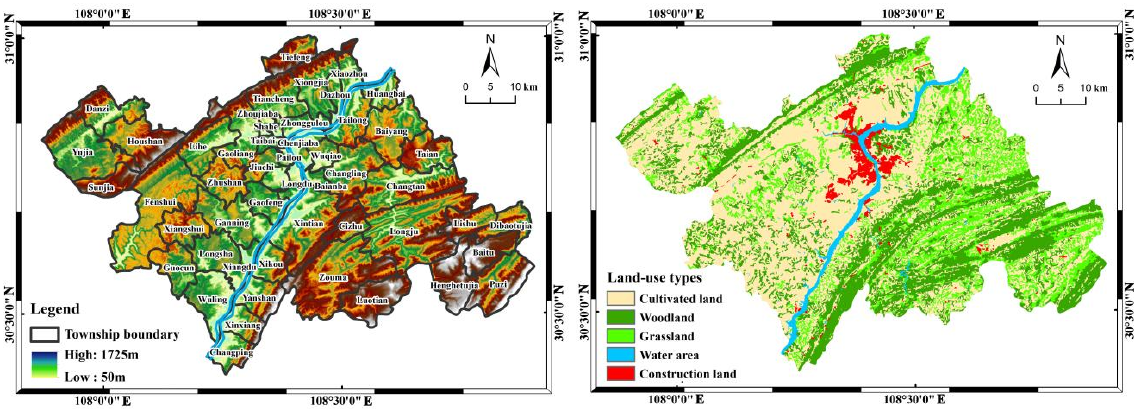
Figure 2. Administrative division of Wanzhou District.